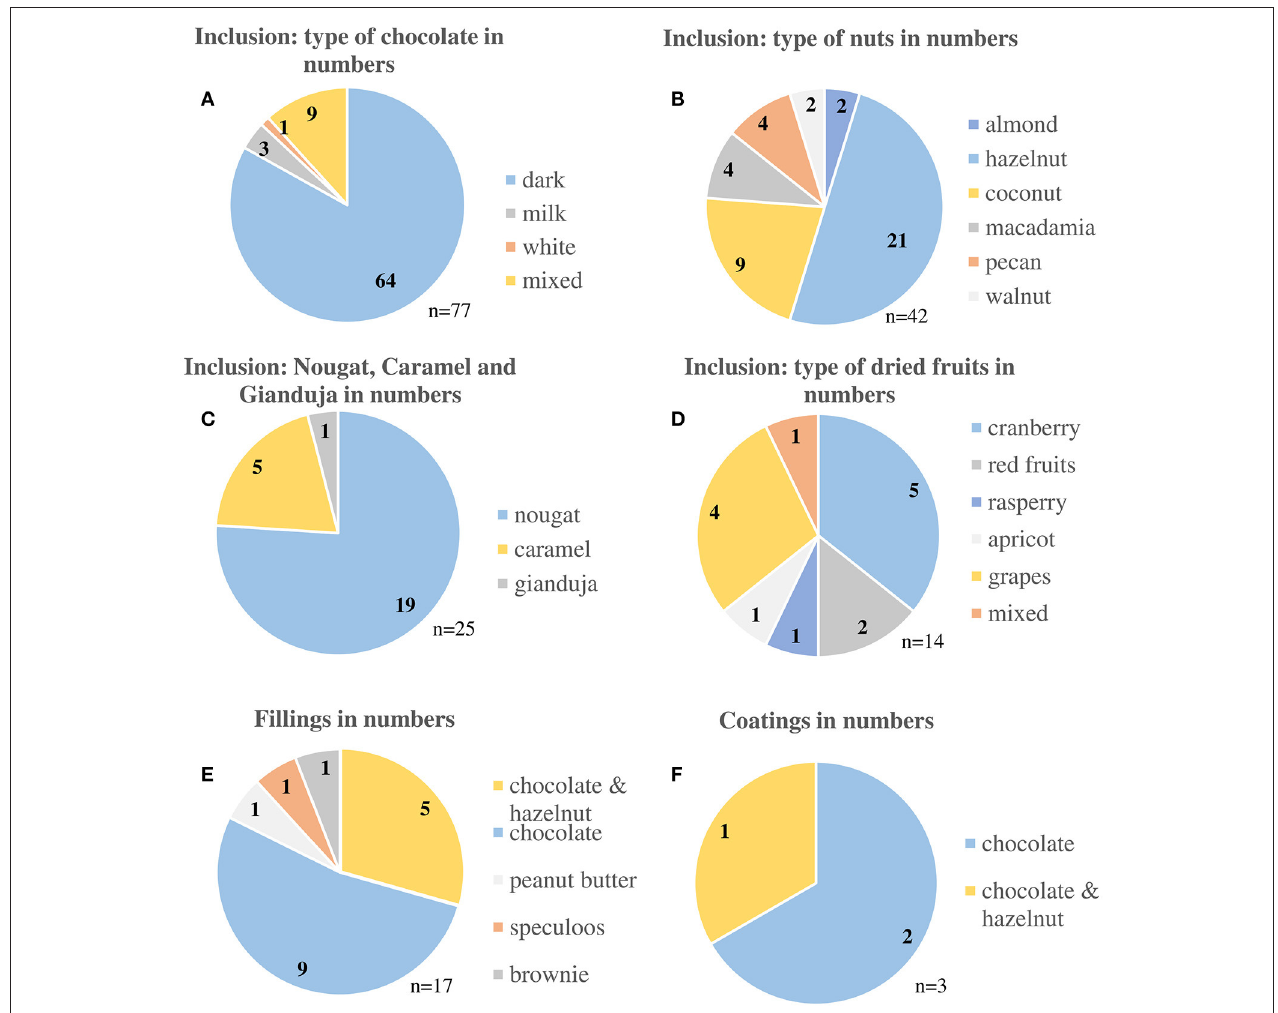
FIGURE 3 | Cookie varieties from the online French market inventory in 2019. Cookies (A–D) are cookies with different inclusions and cookies (E) and (F) are cookies with fillings and